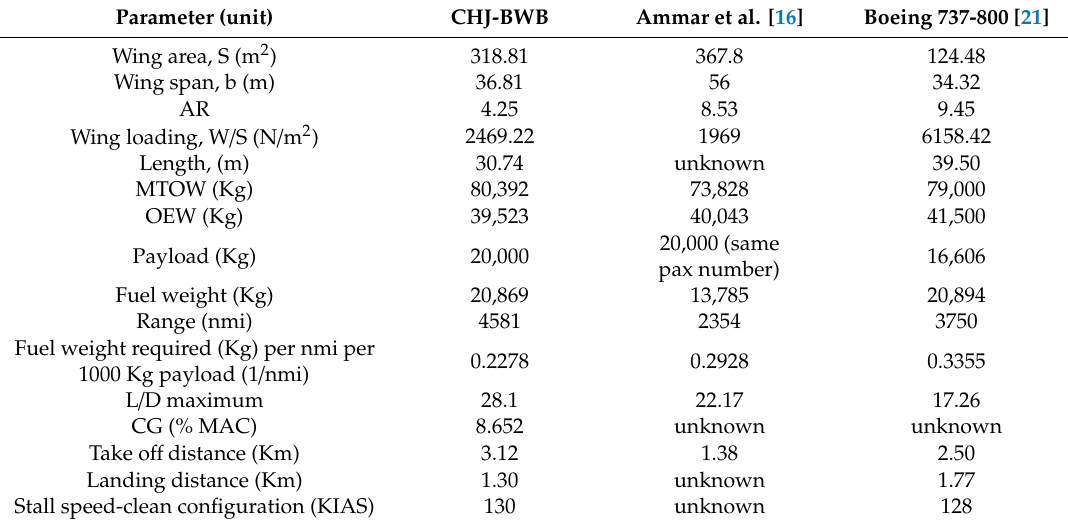
Table 5. Comparison of the conceptual design